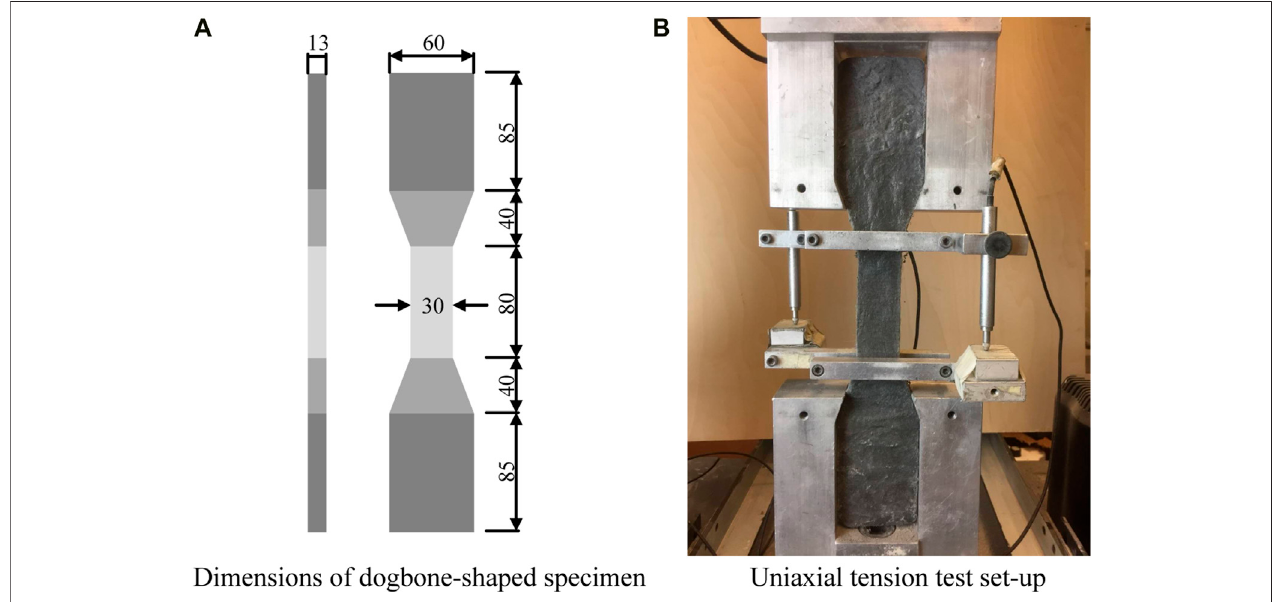
FIGURE 2 | Specimen dimensions and test setup. (A) Dimensions of dog bone-shaped specimen. (B) Uniaxial tension test set-up.